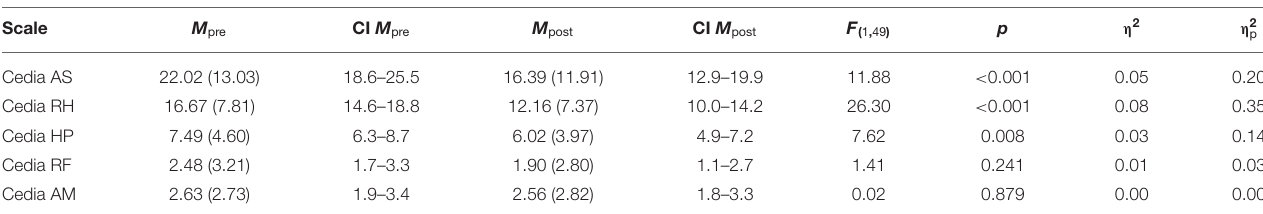
TABLE 3 | Statistics for CEDIA subscales main effects before and after treatment.